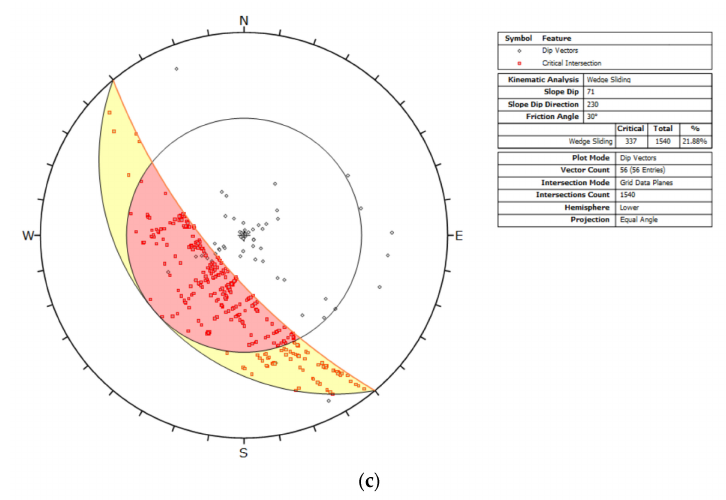
Figure 6. ( a ) Results of sensitivity analysis of kinematic conditions for wedge sliding, exhibiting the variation of percentage of critical intersections with respect to the slope dip direction, and stereonet projection of intersections, highlighting the critical ones for slope dip direction of ( b ) 136 ◦ and ( c ) 230 ◦ .